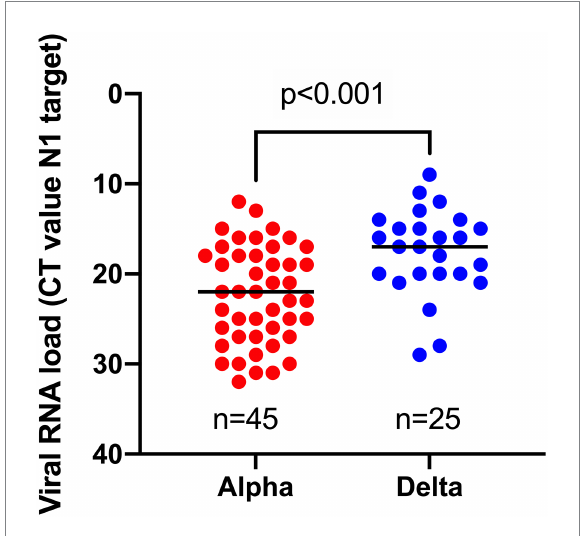
FIGURE 2 Comparison of viral RNA loads, obtained by the same workflow for samples harboring Alpha vs. Delta variant in breakthrough